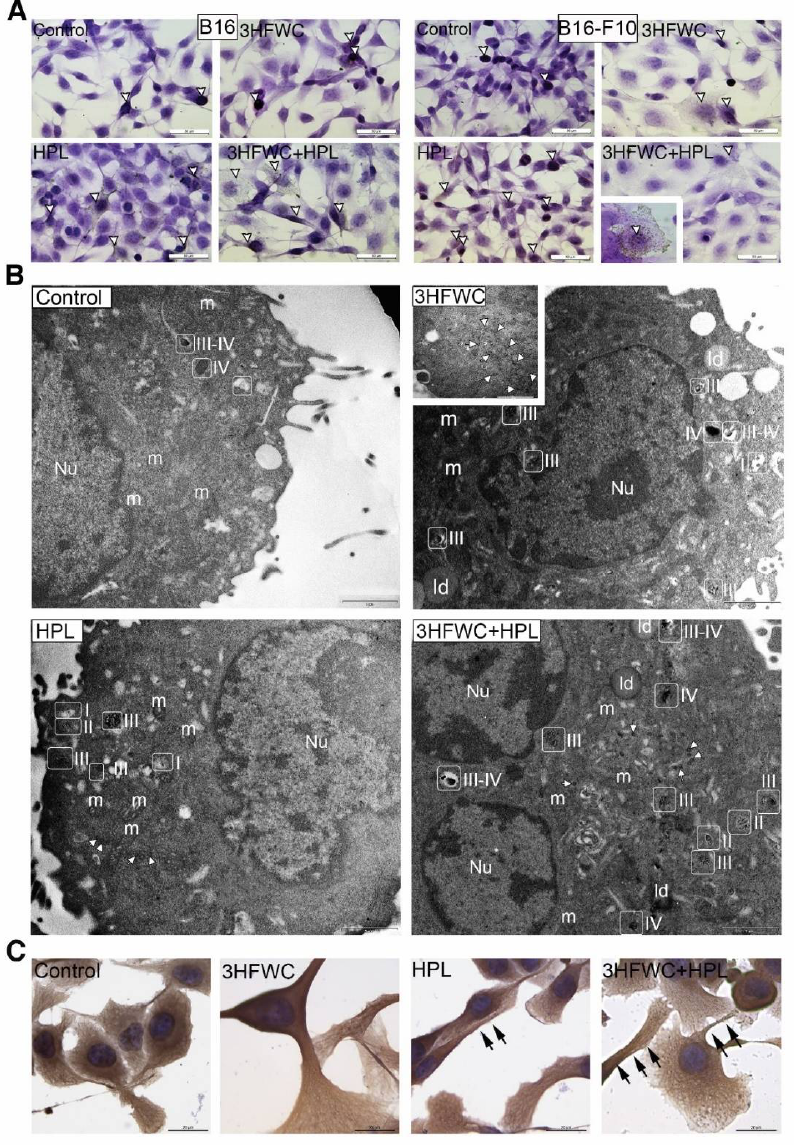
Figure 5. Melanocytic differentiation of B16 and B16-F10 melanoma cells treated with 3HFWC and/or HPL. ( A ) HE staining: occurrence of melanoma cells with brownish mature melanosomes (white triangles); ( B ) TEM: melanosomes in different stages of maturation (I–IV) in B16-F10 cells; small coated vesicles in the cytoplasm (white arrowheads) (Nu—nucleus; m—mitochondrion; ld—lipid droplet); ( C ) immunocytochemical detection of tubulin in B16 cells treated with 3HFWC and HPL; melanosomes along these cytoskeletal elements (black arrows) (magnification and scale bar: A— × 400, 50 µ m; B— × 13,000, 1 µ m; C— × 1000, 20 µ